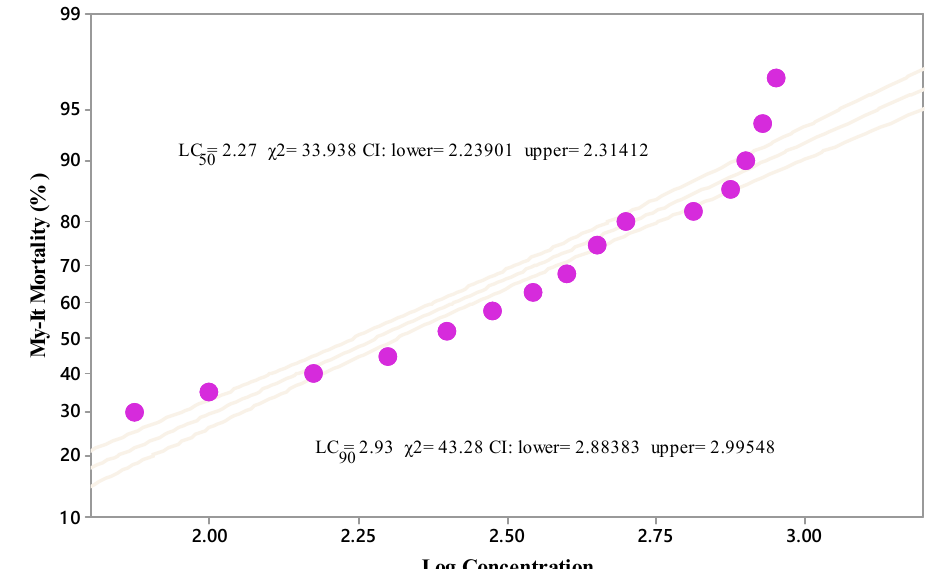
Figure 3. Lethal concentrations (LC 50 and LC 90 ) of My-It conidial spores against fourth instars of Ae. Aegypti , obtained using Probit analysis. Dot represents the lethal concentration of My-It conidial spores against fourth instar larvae of Ae. aegypti .